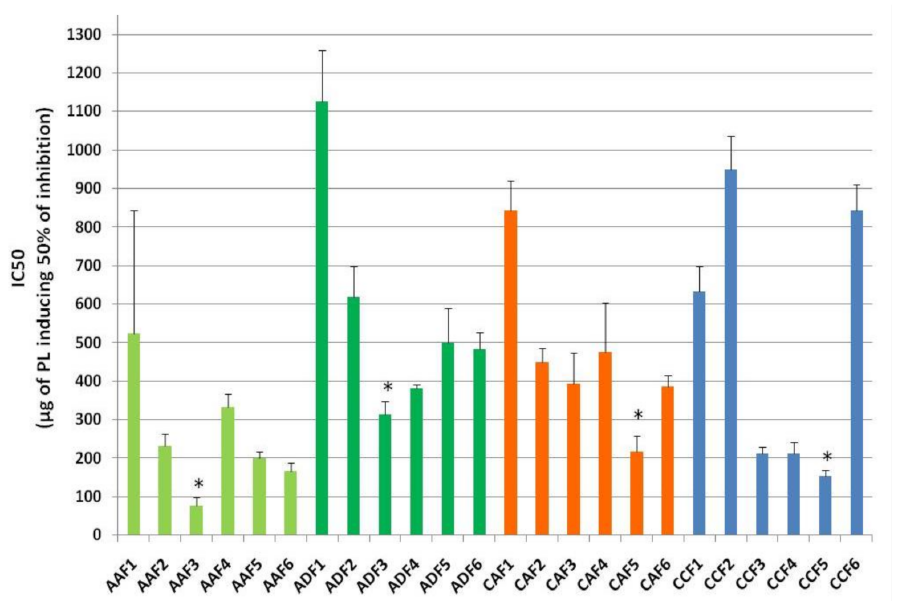
Figure 4. Anti-platelet potency (IC50 values) of HPLC-derived fractions of TPL from apple juice AA (light-green-coloured bars) and AD (dark-green-coloured bars), and cider samples CA (red- coloured bars) and cider CC (blue-coloured bars) against PAF-induced human platelet aggregation. Abbreviations: * denotes statistically significant difference ( p < 0.05) within the same source; F: Fraction; AA and CA: apple juice and cider from apples with low content in tannins (Jonagold), respectively; AD: commercially found apple juice (relevant to the apple juice AA of the Jonagold variety); CC: commercially found cider ‘ Con’s Irish Cider ® ’ (produced by fermentation of a mixture of the aforementioned three different apple juice types in a ratio of 55% Jonagold, 35% Dabinett and 10% Aston